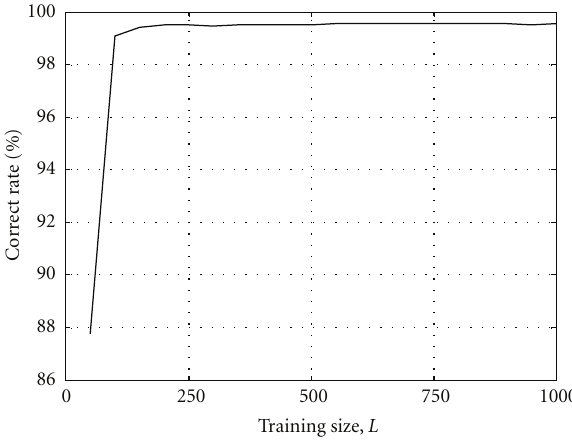
Figure 5: Correct rate of the SVM model with linear kernel for di ff erent training sizes, n = 5.